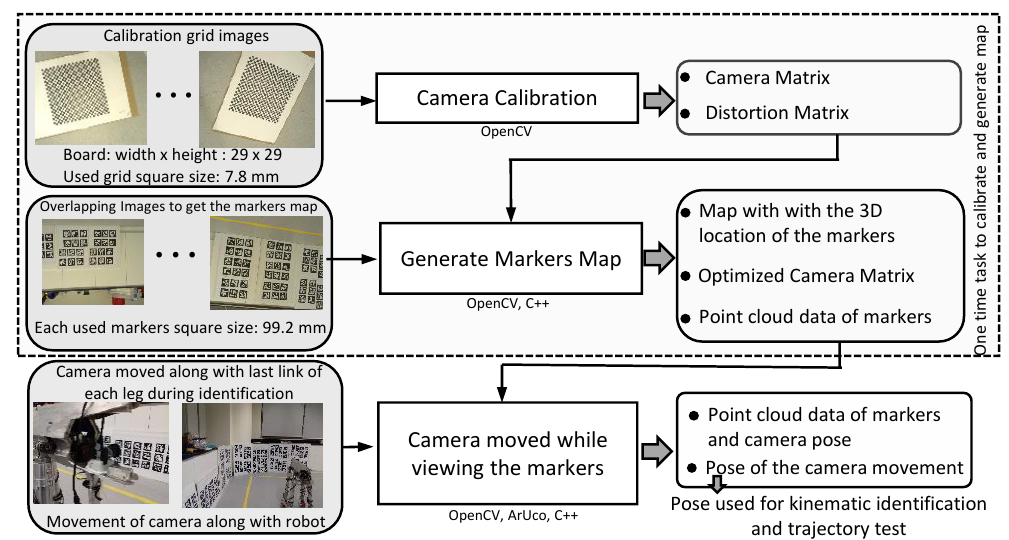
Figure 11. Flow diagram to obtain a pose from the calibrated camera using ArUco